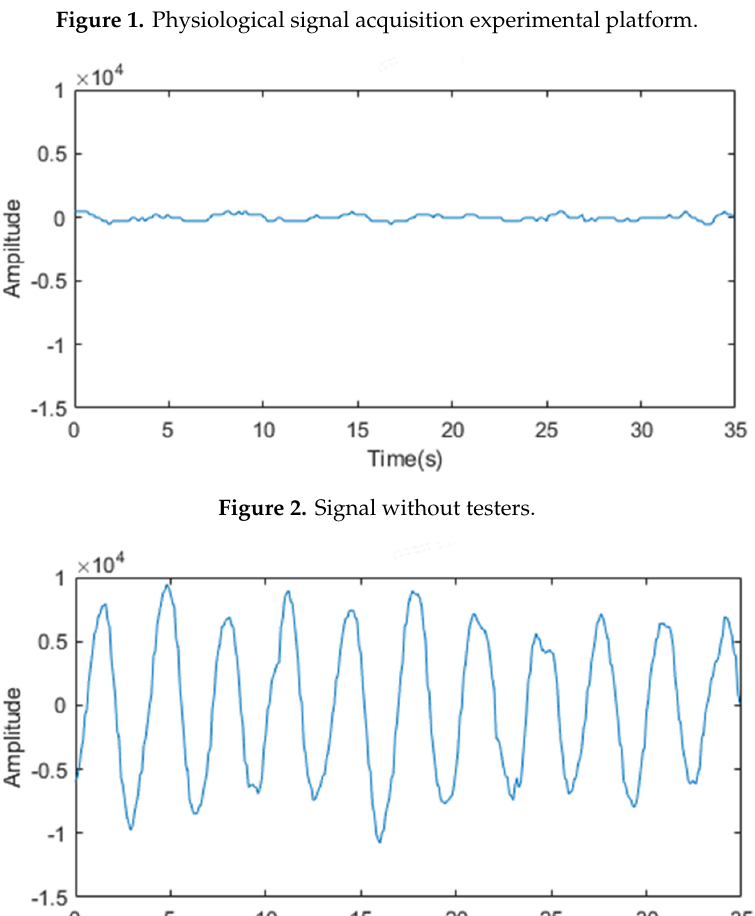
Figure 2. Signal without testers.